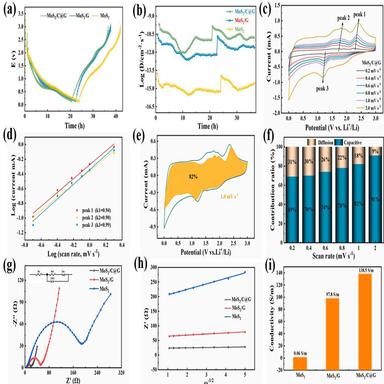
GITT Test Spectra (a) Relationship between time and potential, and (b) Relationship between time and LogD; (c) Different sweep speed CV, (d) The relationship between the computed b-value and log(i) versus log(v), (e) Capacitive contribution, (f) Capacitance ratios of the MoS2/C@G electrode at various sweep rates; (g) EIS spectra and (h) Comparison of Z' and ω-1/2 of the three materials; (i) Diagram of electrical conductivity.